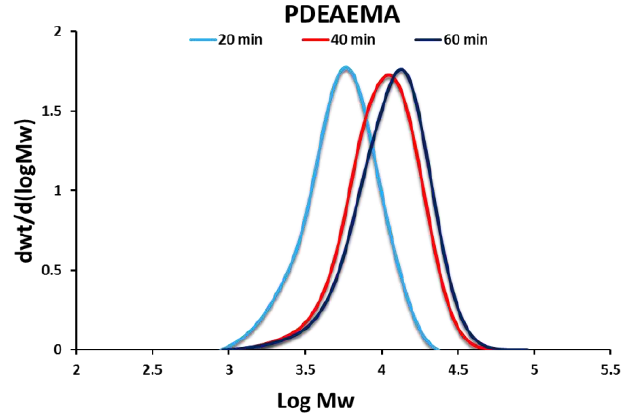
Figure 2. Gel Permeation Chromatography (GPC) traces of SG1-terminated PDEAEMA at various reaction times. DEAEMA (0.26 mol, 47.57 mL), styrene (0.03 mol, 3.47 mL), NHS-BlocBuilder® (2.9 mmol, 1.4038 g), SG1 (0.32 mmol, 0.1022 mL). Polymerization was run at 80 °C for 1 h.